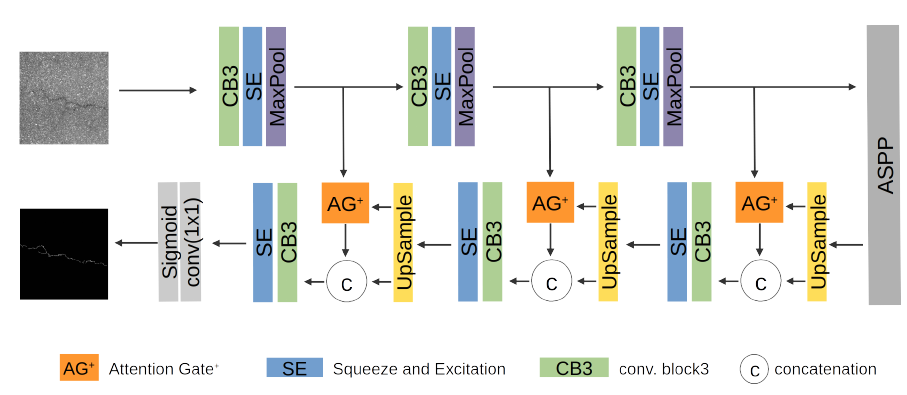
Figure 1. Architecture of the proposed model.